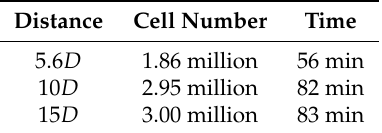
Table 8. Computational run time for each distance on a fine mesh.